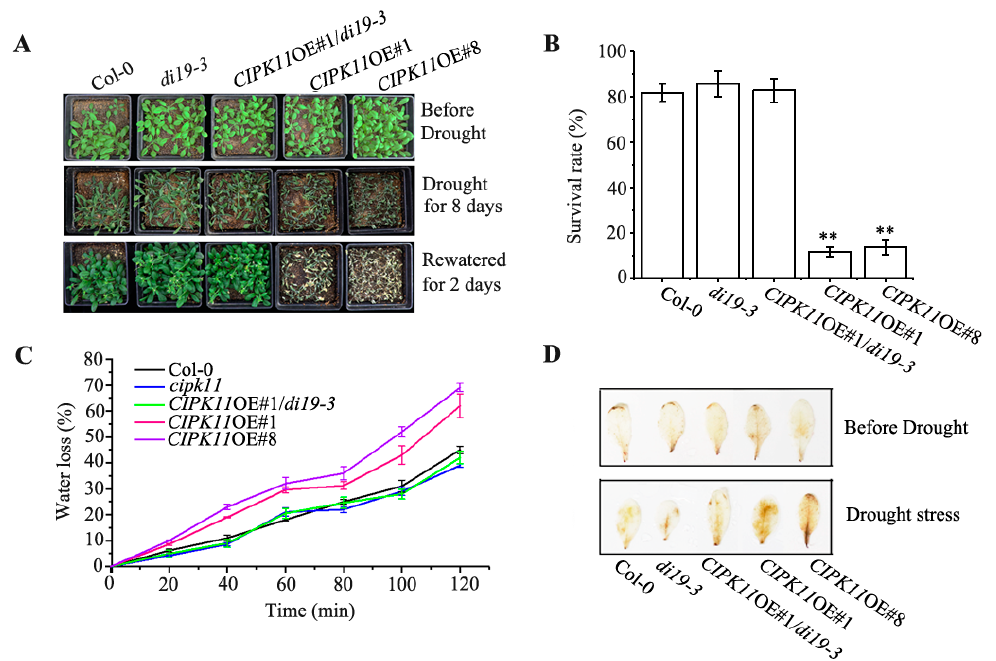
Figure 5. Genetic Interaction of CIPK11 with Di19-3 under drought stress. ( A ) Drought-resistance assay. Col-0, di19-3 , CIPK11 OE#1/ di19-3 , CIPK11 OE#1, and CIPK11 OE#8 plants grown under normal growth conditions for 28 days were subjected to drought stress condition for eight days and then re-watered for two days. ( B ) Survival rate after drought treatment for 10 days ( n = 4 biological replicates, 16 plants in each replicate). Data represent means ± SD. The Asterisks above the columns indicate significant difference between means (** p < 0.01; Student’s t -test). ( C ) Water loss in Col-0, di19-3 , CIPK11 OE#1 / di19-3 , CIPK11 OE#1, and CIPK11 OE#8 leaves ( n = 4, each replicate includes three fully expanded leaves from five-week-old plants grown in soil and subjected to drought for four days. Data represents means ± SD. ( D ) H 2 O 2 content in Arabidopsis under drought treatment. DAB staining assay of rosette leaves of Col-0, di19-3 , CIPK11 OE#1 / di19-3, CIPK11 OE#1, and CIPK11 OE#8 after drought stress.